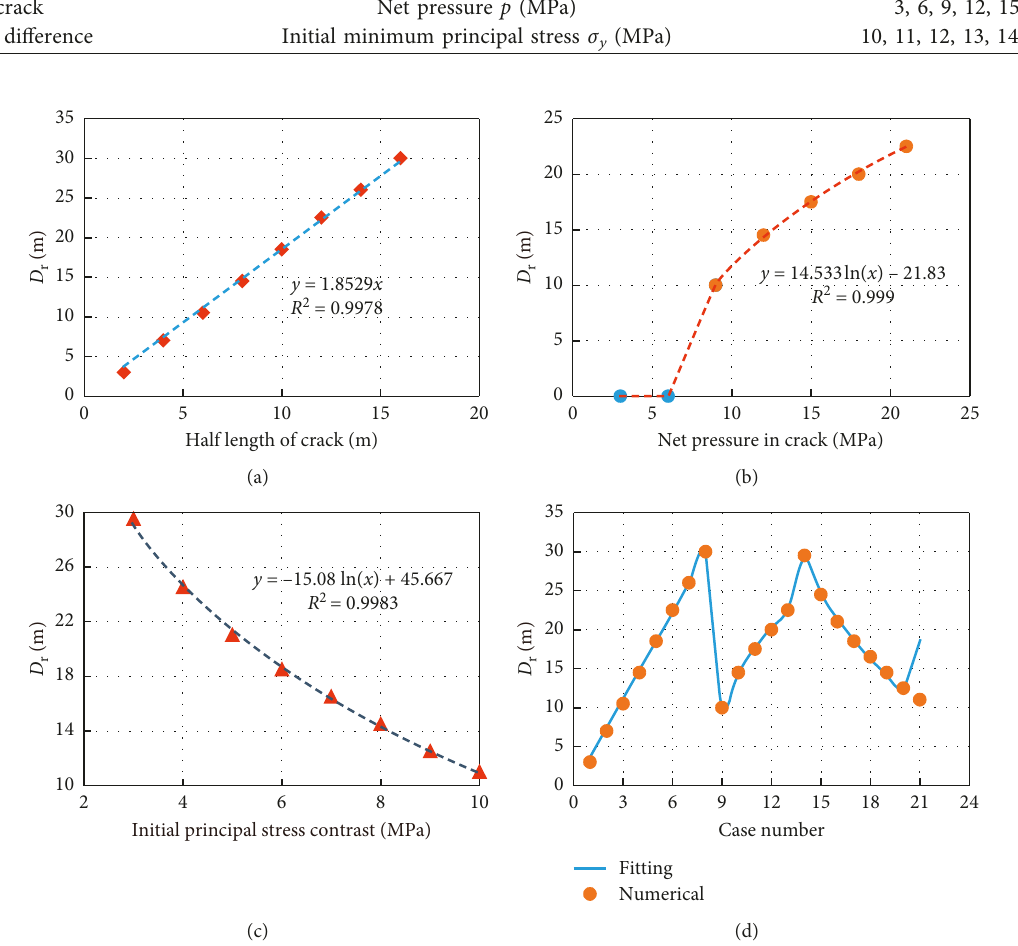
Figure 8: Relationship between stress reorientation range and (a) half-length of crack, (b) net pressure in crack, (c) initial stress contrast, and (d) different